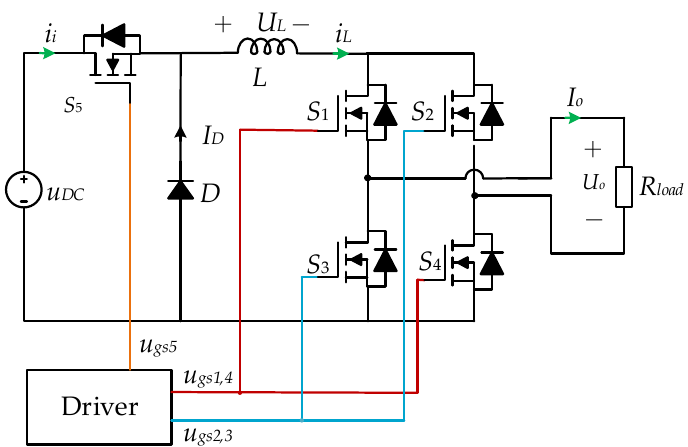
Figure 6. Topology of the capacitor-free inverter . Figure 5. Topology of the capacitor-free